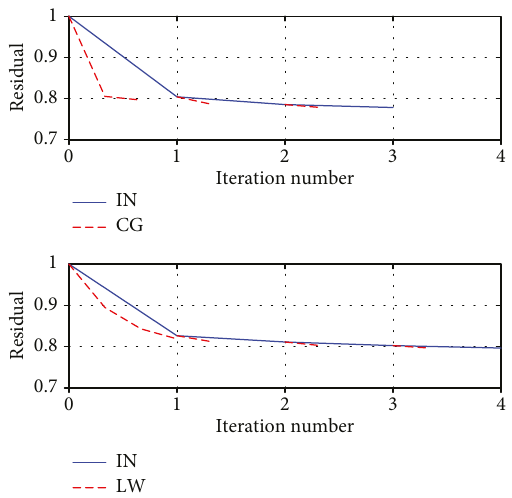
Figure 10: Behaviour of the normalized data residuals for the conjugate gradient-based (top, p = 1 3 ) and Landweber-based opt (bottom, p = 1 2 ) methods versus the iteration number. opt Residuals in the outer inexact Newton (IN) iterations and in the inner conjugate gradient (CG) and Landweber (LW) loops are reported. Dielectric sphere and cylinder with ϵ = 4 . r ,1 Table 2: Optimal values of p , normalized mean squared error ( e ), inv ), and number of outer iterations U average relative errors ( e opt t / b versus SNR with p = p and p = 2 . Figure 11: Reconstructed distribution of the dielectric permittivity opt for the signal-to-noise ratio SNR = 20 dB . (a) p p = 2 . Inhomogeneous cylinder.